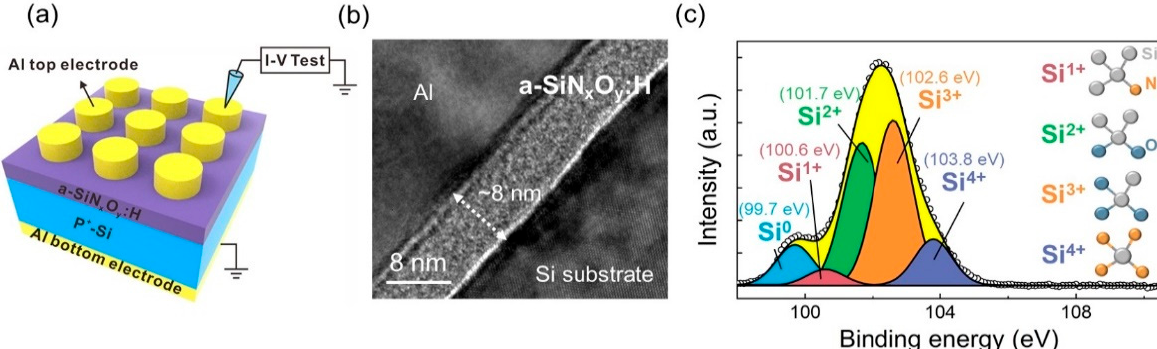
Figure 1. ( a ) Schematic illustration of the Al/a-SiN x O y :H/P + -Si RRAM device with electrical meas- urement; ( b ) Cross-sectional HRTEM image of the Al/a-SiN x O y :H/P + -Si RRAM device; ( c ) XPS spec- trum of the as-deposited a-SiN x O y :H film.